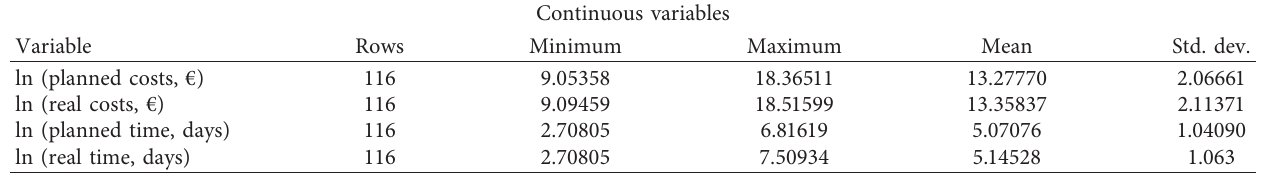
Table 2: Minimal, maximal, mean value and standard deviation for the numerical variables (predictors and target).